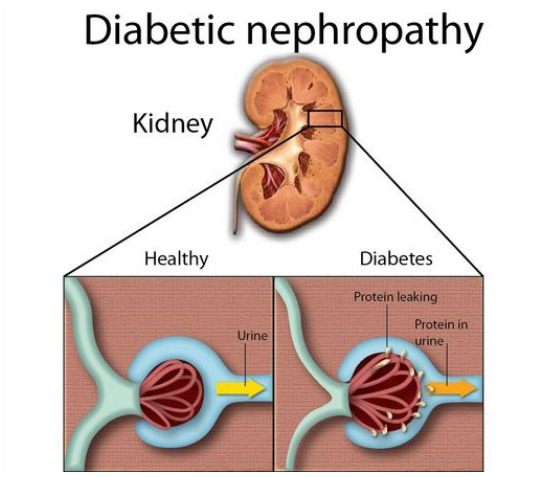
Figure 2. Difference between kidney functioning in healthy and diabetes patient